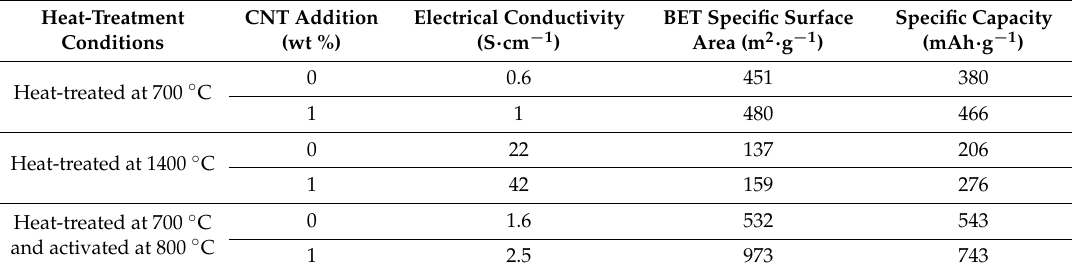
Table 3. Electrical conductivities, BET specific surface areas and specific capacities of carbon nanofibers and the CNT-carbon nanofibers carbonized and activated at each temperature.